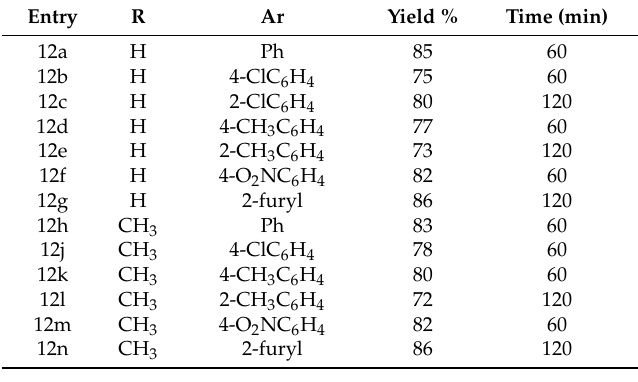
Table 1. Synthesis of pyridazino[5,4,3- de ][1,6]naphthyridine derivatives 12a – n .